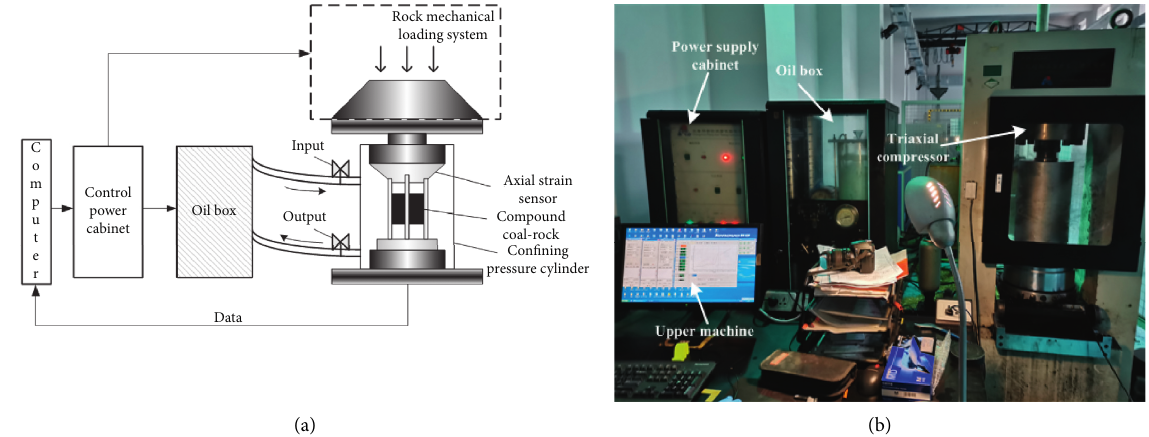
Figure 2: Test equipment and the scene. (a) Laboratory equipment. (b) Test on